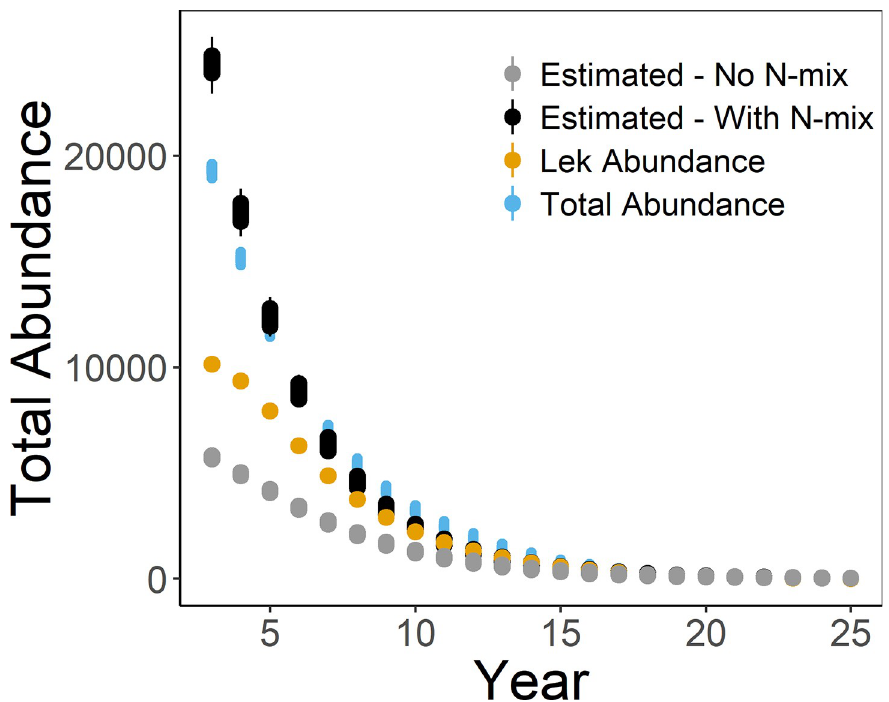
Fig 4. Comparison of analytical methods. Abundance of total lesser prairie-chickens (“Total Abundance”; blue) and the number of lekking lesser prairie-chickens (“Lek Abundance”; yellow) from individual-based model simulations with density-based lek attendance and detection probability analyzed with an N-mixture model (“Estimated–With N- mix”; black; Scenario 4N) and without an N-mixture model (“Estimated–No N-mix”; gray; Scenario 4). Points represent mean or true values from each simulation and whiskers represent 95% quantiles for each simulation.